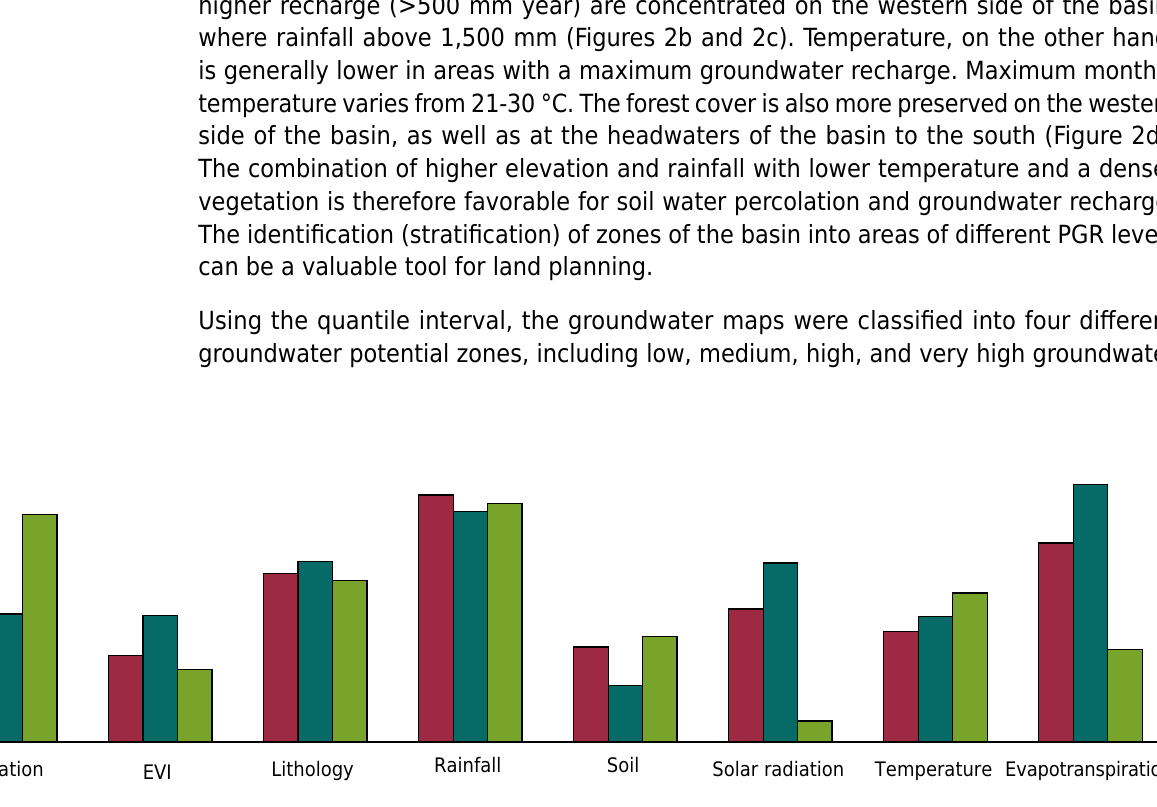
Table 4. Statistical distribution of the groundwater recharge predicted for the Doce River Basin for two hydrological years Period